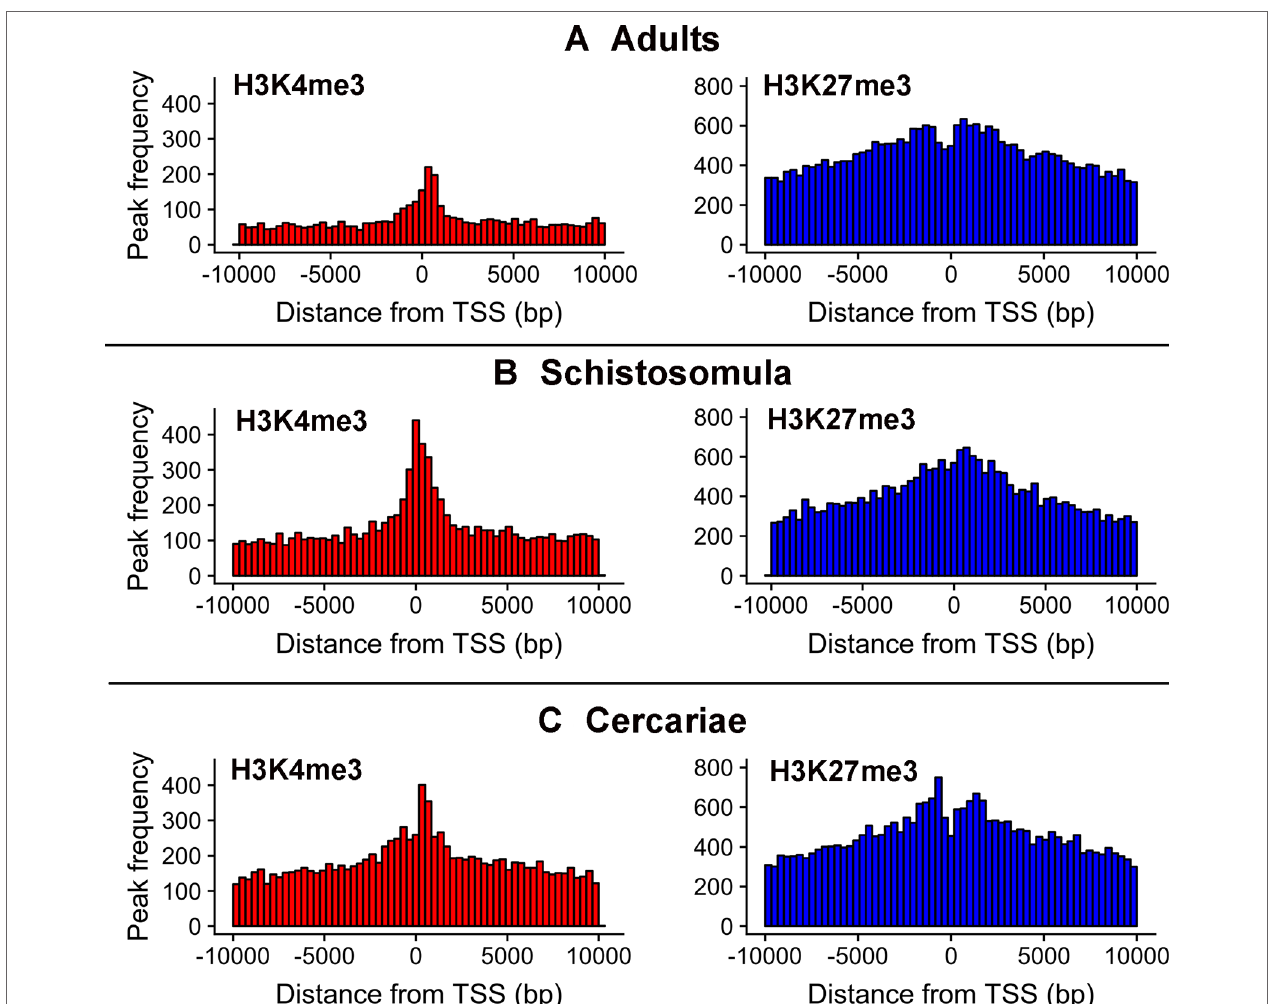
FIGURE 4 | Epigenetic histone marks H3K4me3 and H3K27me3 surrounding the TSS of S. mansoni lncRNAs. The frequency of the H3K4me3 marks (red) or of the H3K27me3 marks (blue) mapping within 10 kb around the TSS of all lncRNAs in (A) adults, (B) schistosomula and (C) cercariae was